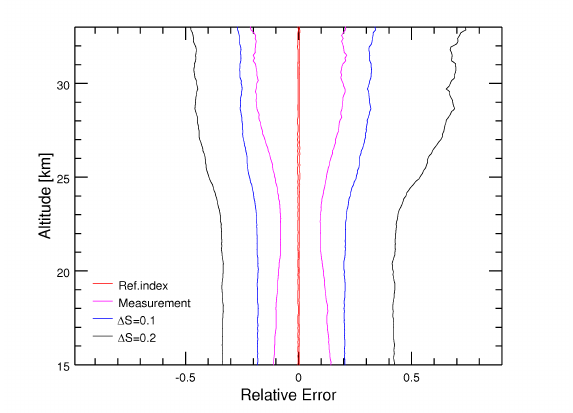
Figure 8. Relative error of the median radius ∆ r m / r m due to measurement errors, uncertainties in the distribution width ( ∆ S ), and the aerosol refractive index ( ∆ n A